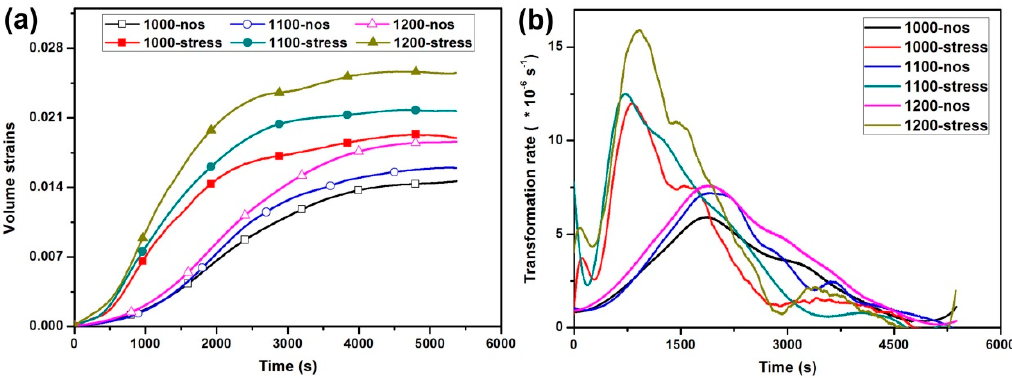
Figure 6. The volume strains and bainitic transformation rates of the different specimens during the bainitic transformation at 330 °C: ( a ) volume strains and ( b ) bainitic transformation rates.